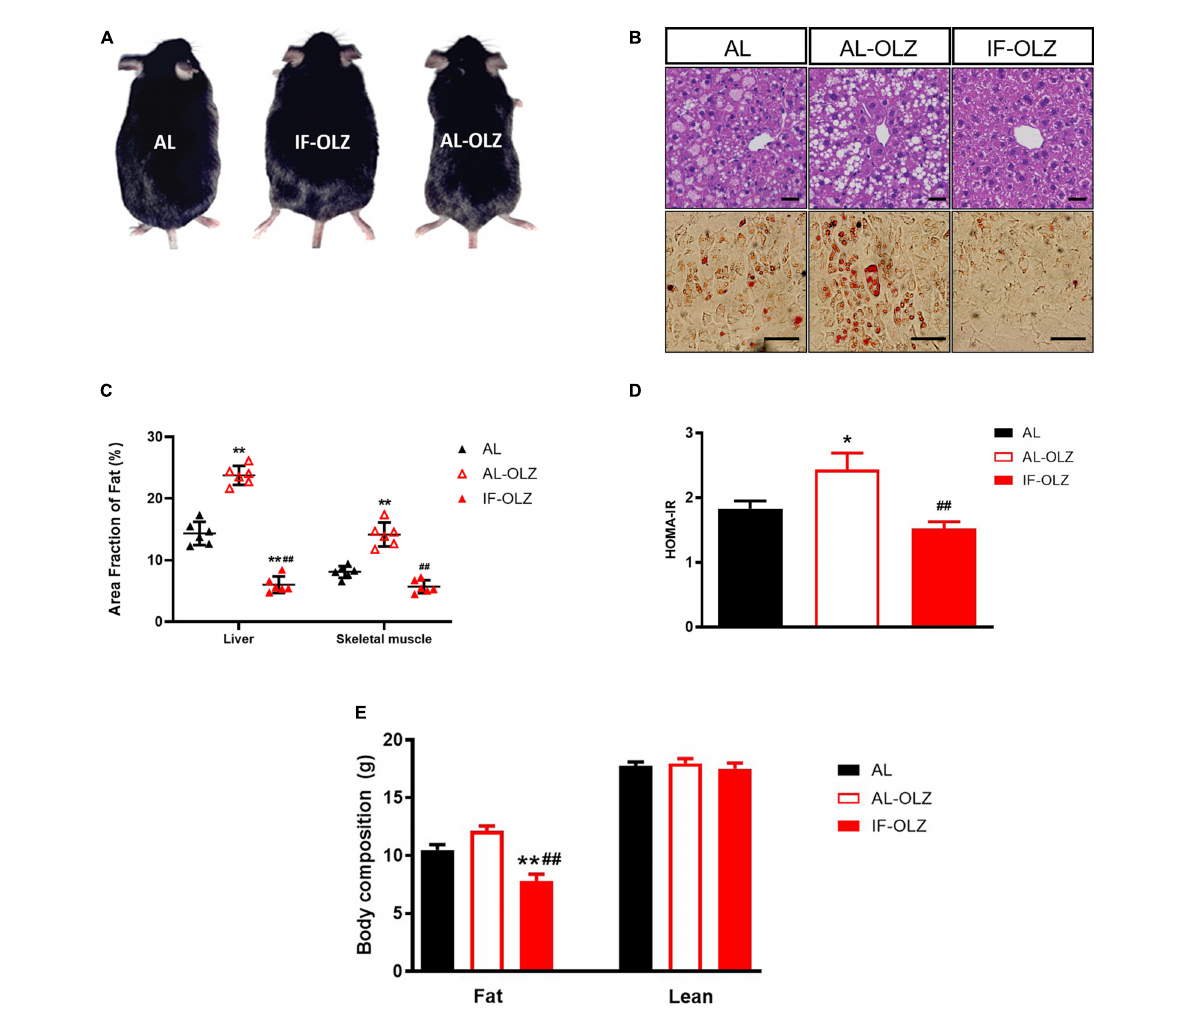
FIGURE2 Effect of IF on liver and skeletal muscle steatosis, HOMA-IR and body composition. (A) Representative images of AL, AL-OLZ, and IF-OLZ mice. (B) Representative H&E-stained sections of liver (upper) and Oil Red O-stained sections of skeletal muscle (lower), scale bars: 50 µ m. (C) Average area fraction of fat (%) in liver and skeletal muscle were measured using ImageJ software. (D) HOMA-IR in AL, AL-OLZ, and IF-OLZ mice. (E) Body composition showing fat and lean mass. For each animal group, n = 6. One-way ANOVA plus Tukey’s test was performed for the data analysis. Mean ± SD; * P < 0.05 and ** P < 0.01 vs. AL; ## P < 0.01 vs.